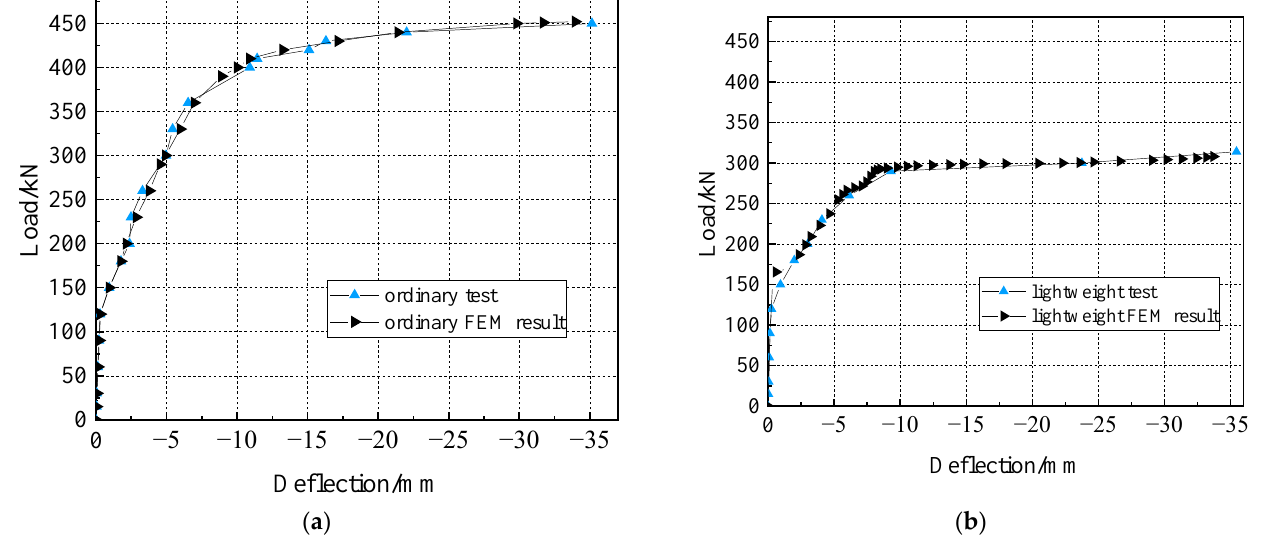
Figure 11. Load – deflection curve of FEM. ( a ) Ordinary specimen. ( b ) Hollow specimen. The displacement results show that the finite element simulation is accurate for ordinary structures, with the ultimate load error of 0.44% and the ultimate displacement error of 3.36%. For the hollow structure, the finite element calculation makes some errors when approaching the cracking load, and the ultimate bearing capacity error is 1.91%. The error of the limit displacement is 4.42%. This result shows that the finite element model accurately and effectively simulates the actual structure.